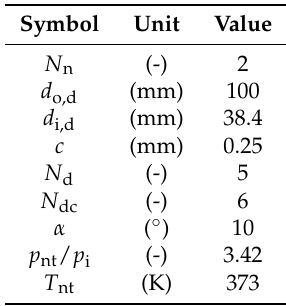
Table 2. Geometrical and aerodynamic